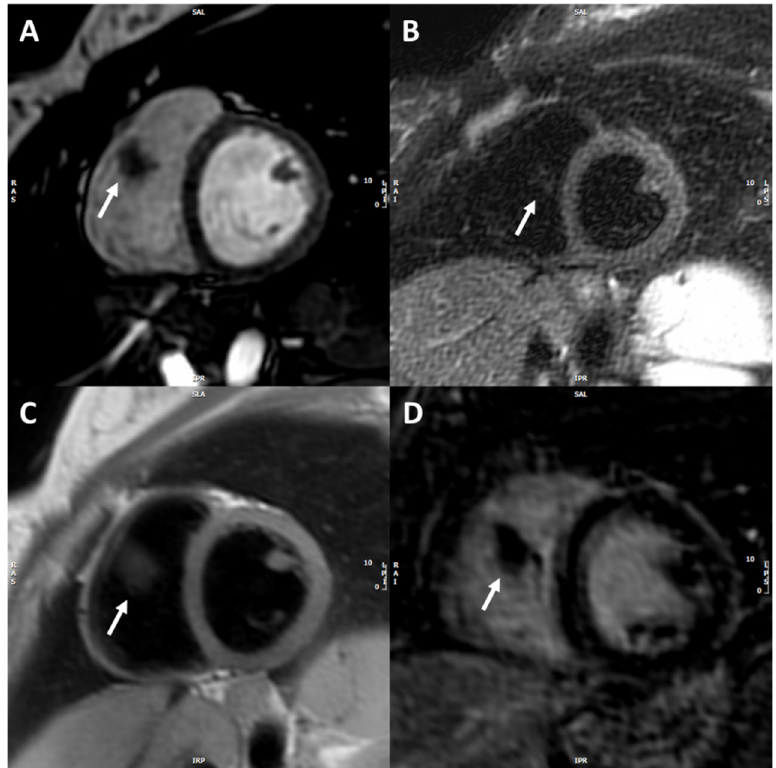
Figure 2. Cardiac magnetic resonance depicting right non-vascularized intracardiac mass. CMR images: Cine SSFP short-axis image ( A ) showing the mass in the right ventricle (white arrow) with irregular borders. STIR T2-weighted ( B ) and FSE T1-weighted short-axis images ( C ) showing the lower signal intensity of the mass compared to the myocardium. Late post-contrast short-axis image ( D ) showing no-contrast uptake from the mass.